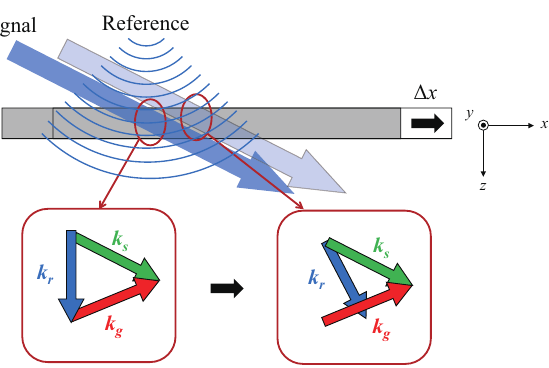
Figure 1. Principle of the peristrophic multiplexing.